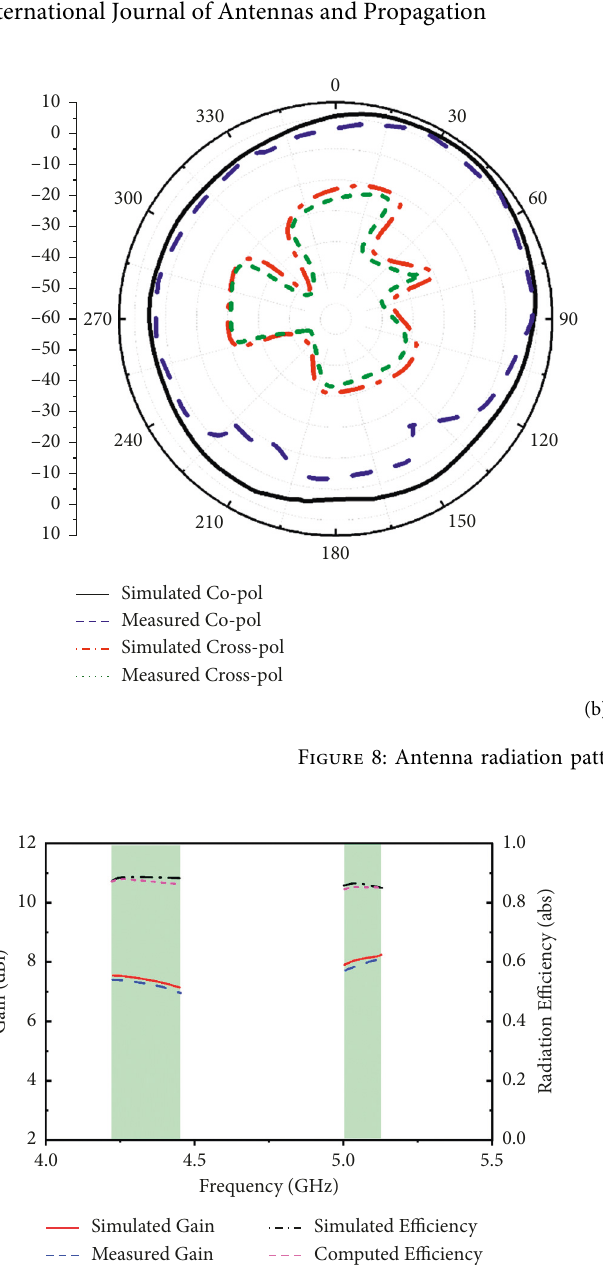
Figure 9: Variation of gain and efficiency with frequency. Figure